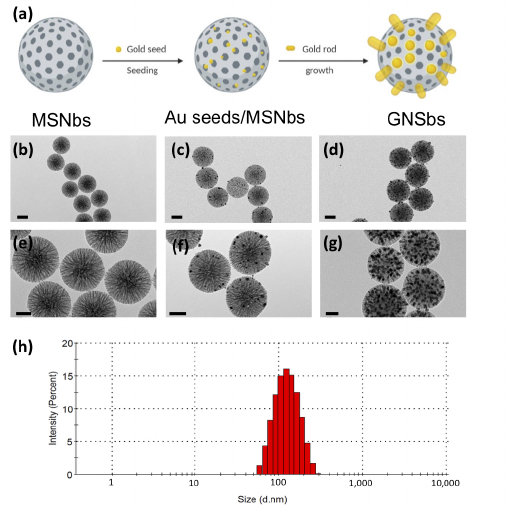
Figure 1. The synthesis and morphology of the gold nano-sesame-beads (GNSbs). ( a ) Schematic illustration of GNSbs. TEM images of ( b , e ) the mesoporous silica nanobeads (MSNbs), ( c , f ) the gold-seed-filled porous silica nanobeads (GSNbs), ( d , e ) the gold nano-sesame-beads (GNSbs). ( h ) The particle size distribution of GNSbs. Scale bar = 100 nm in ( b,c,d ). Scale bar = 50 nm in ( e,f,g